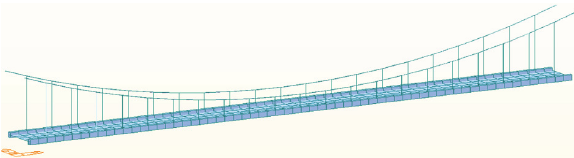
Fig. 3. A finite element space model of the bridge